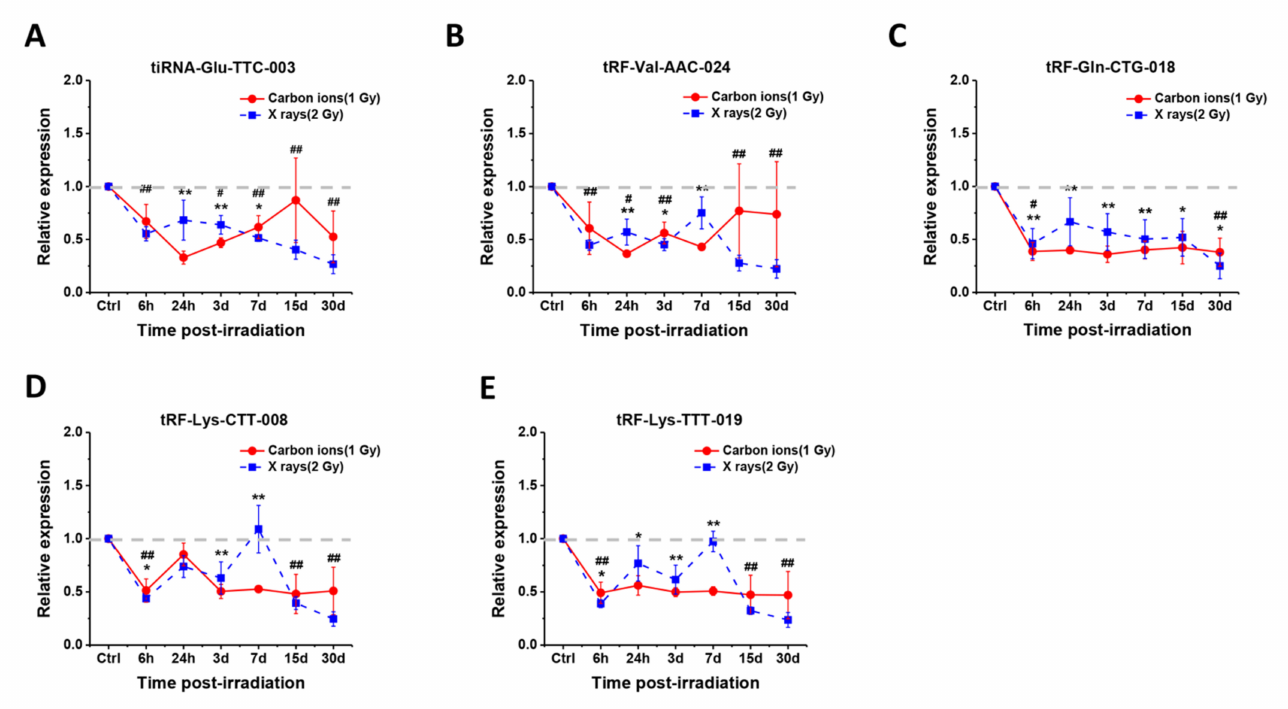
Figure 4. Temporal changes of the five selected tsRNAs in serum of mice after carbon ion or X-ray exposure. ( A – E ) Rela- tive expression of the five selected tsRNAs (tiRNA-Glu-TTC-003, tRF-Val-AAC-024, tRF-Gln-CTG-018, tRF-Lys-CTT-008, and tRF-Lys-TTT-019) from 6 h to 30 days (d) after exposure of mice to 1 Gy of carbon ions or 2 Gy of X-rays. The baseline of the expression is indicated by a grey dotted line. In groups of carbon ion irradiation, * p < 0.05, ** p < 0.01; in groups of X-ray irradiation, # p < 0.05, ## p < 0.01; compared with control group (0